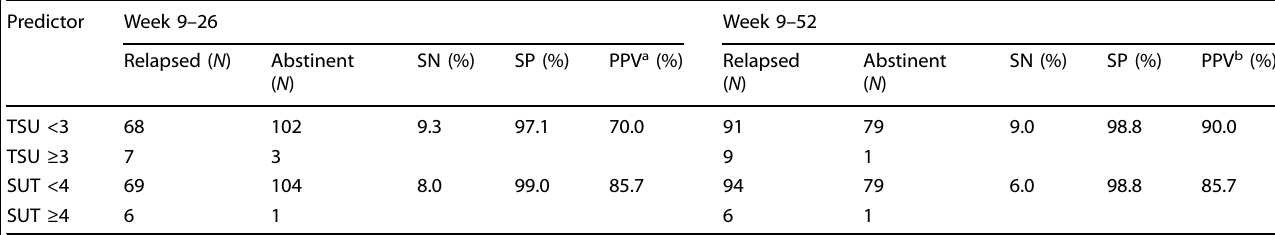
Table 2. Diagnostic parameters for urges to smoke measures as predictors of relapse during week 9 – 26 and week 9 – 52.